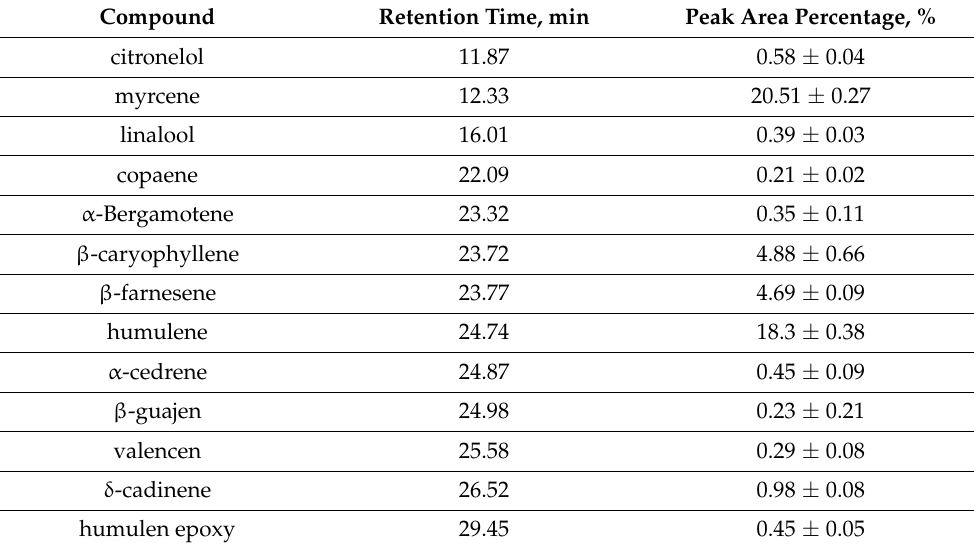
Table 1. The quality profile (% peak area) of crude extract (E1) obtained from Polish “Marynka” hop variety.